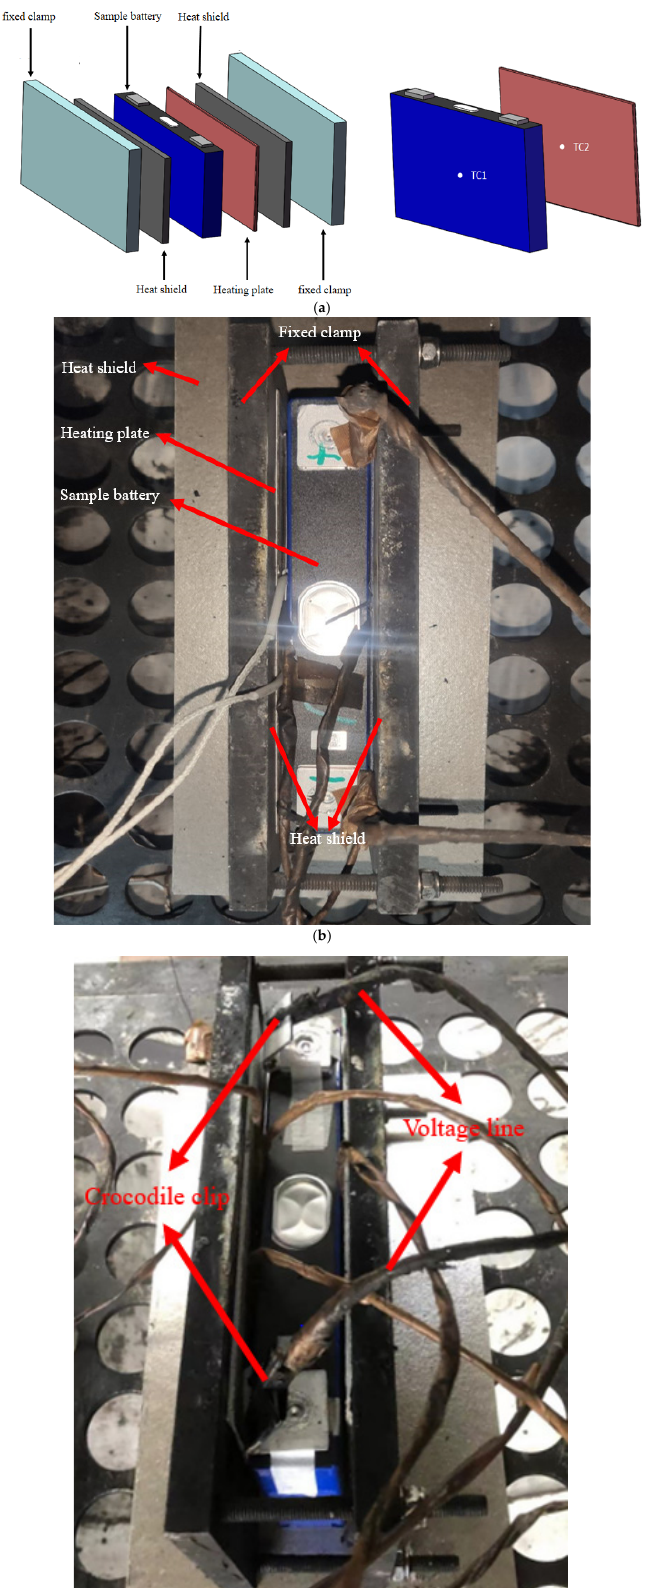
Figure 2. Layout diagram of the experimental battery. ( a ) Schematic diagram of experimental arrangement. ( b ) The layout of the experiment. ( c ) Voltage measurement wiring diagram. During the experiment, the battery is arranged on the bench, and multiple thermo ‐ couples are arranged to measure the average ambient temperature in the test chamber. The TR of four battery samples were triggered under a nitrogen (N 2 ) atmosphere, in which nitrogen had three effects: 1. As carrier gas; it will produce a dry inert oxygen ‐ free atmos ‐ phere; 2. Prevent the risk of fire outbreak in the reaction vessel; 3. Control the temperature of the gas released from the reaction vessel at a manageable level for chemical analysis and quantitative analysis. A lithium iron phosphate battery will generate massive electro ‐ lytes, particles, and some gases after the TR. In order to ensure that the gas composition measurement is more accurate for the lithium iron phosphate battery, we first heated the ambient temperature in the experimental cabin to 150 °C, waiting for three minutes to make the cabin temperature more stable. We then turned on the heating plate on the side of the battery, heating until the battery thermal runaway. The purpose of doing so was to make the ambient temperature reach the boiling point of the electrolyte inside the battery, so that the electrolyte would vaporize and change into a gaseous state during the eruption process, and therefore more accurate gas volume and gas composition could be obtained [36]. The experimental steps mainly include the following points: (1) Measure the open circuit voltage of the battery, ensure that the battery is in the spec ‐ ified state of charge, and record the initial quality of the battery before the test;